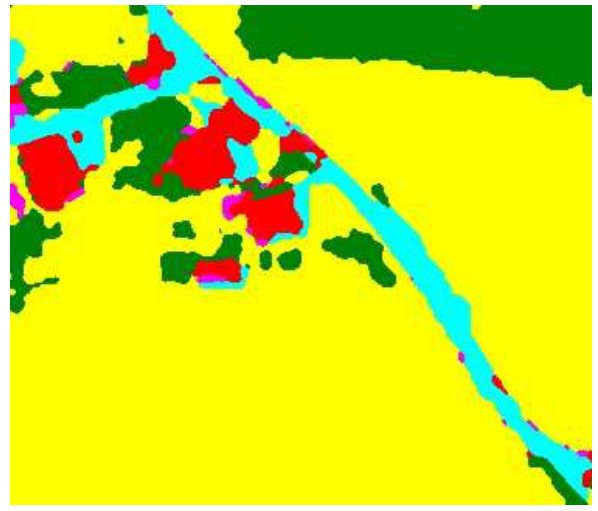
Figure 2. Sample of the original image classification